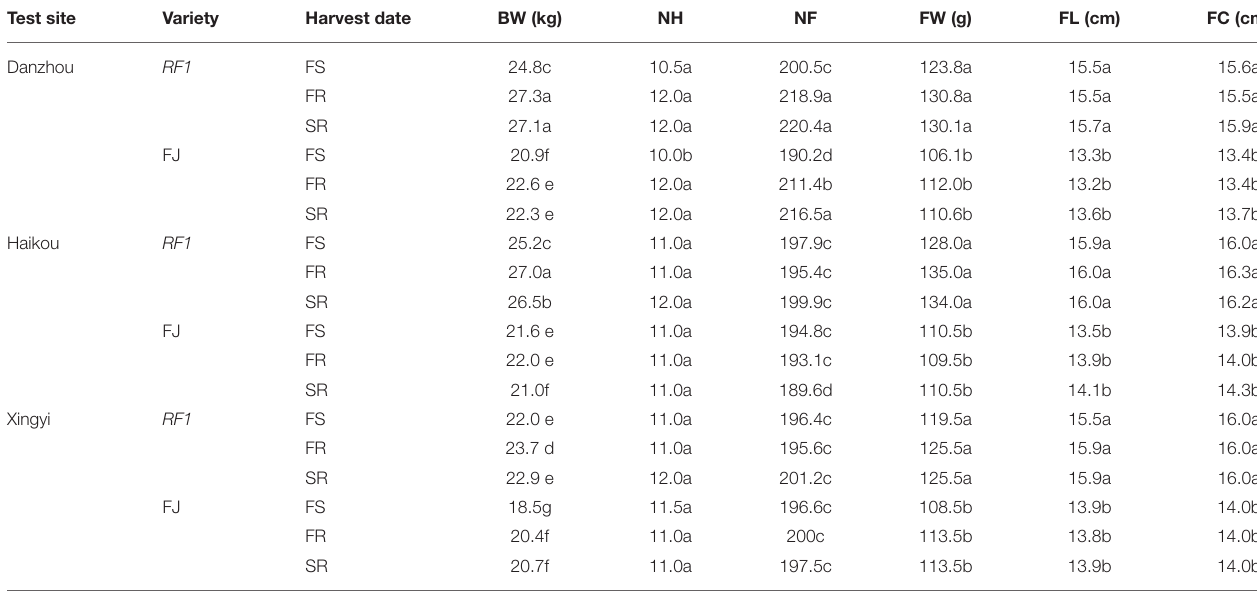
TABLE 3 | Yield assessment of RF1 and FJ at multiple field